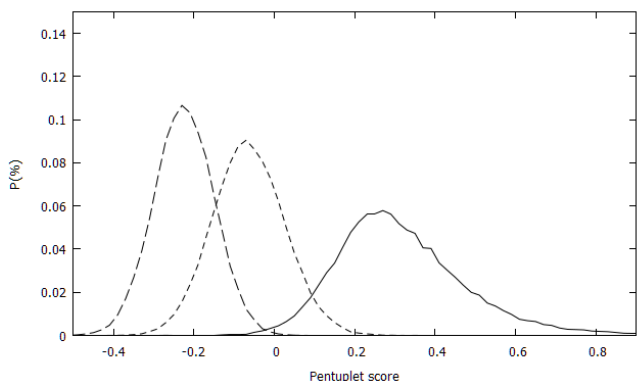
Figure 1. Pentuplet score distributions for the experimental set (full line), randomly generated from the uniform amino acid distribution (short dashes) and randomly generated with amino acids sampled with their natural propensity (long dashes).